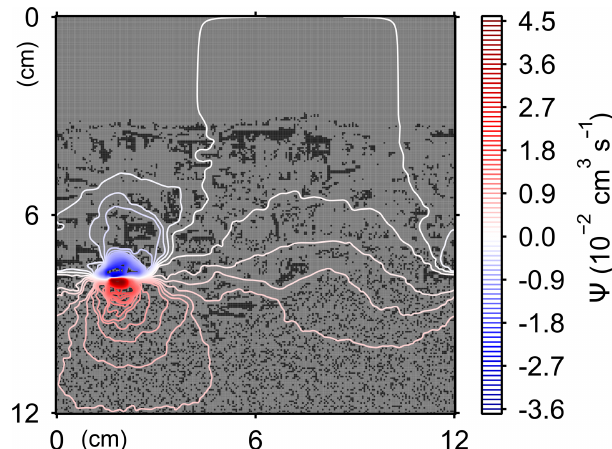
Figure E1. Stream function calculated at 175 model days in simu- lation with water flows increased at the time of ingestion/egestion by a factor of 10 4